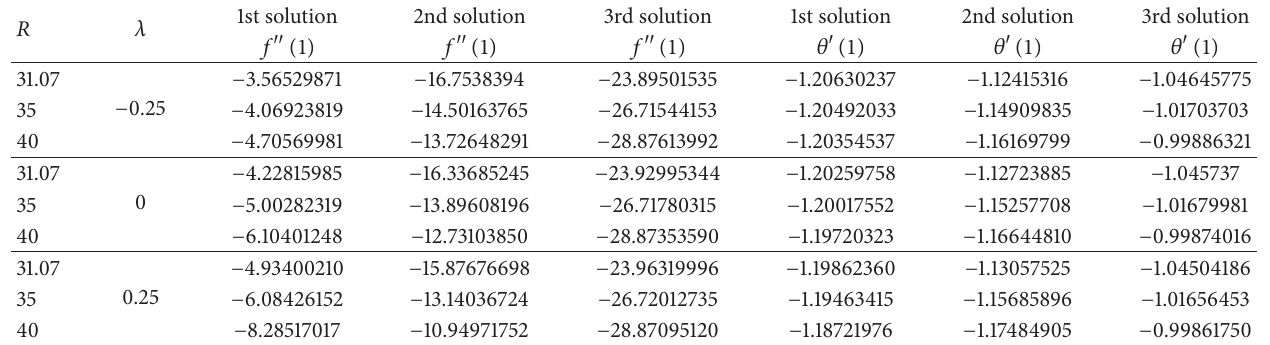
Table 2: Skin friction and temperature gradient for different values of Reynold number 𝑅 .